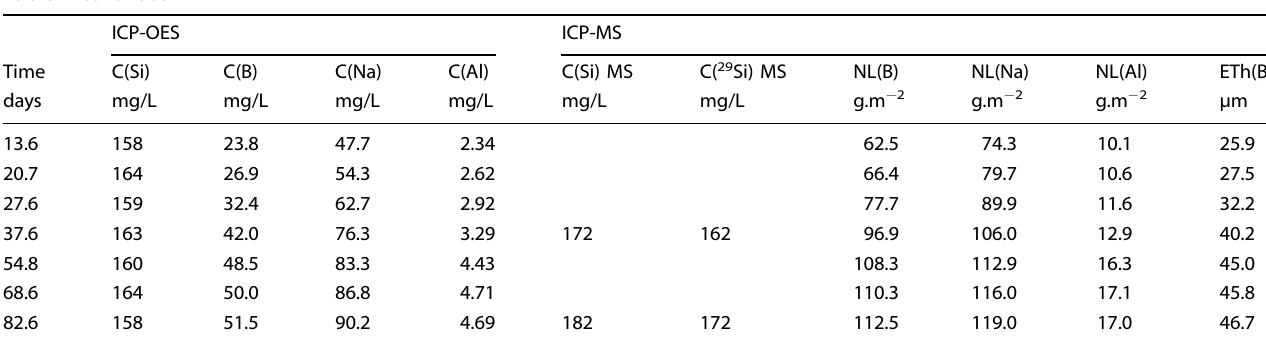
Table 2 groups the data obtained for the gel thicknesses,